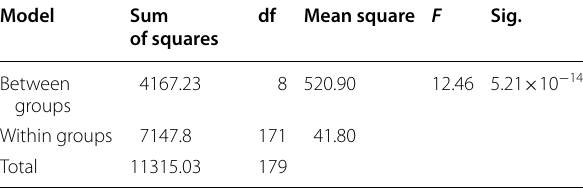
Table 9 Variance analysis results of door width